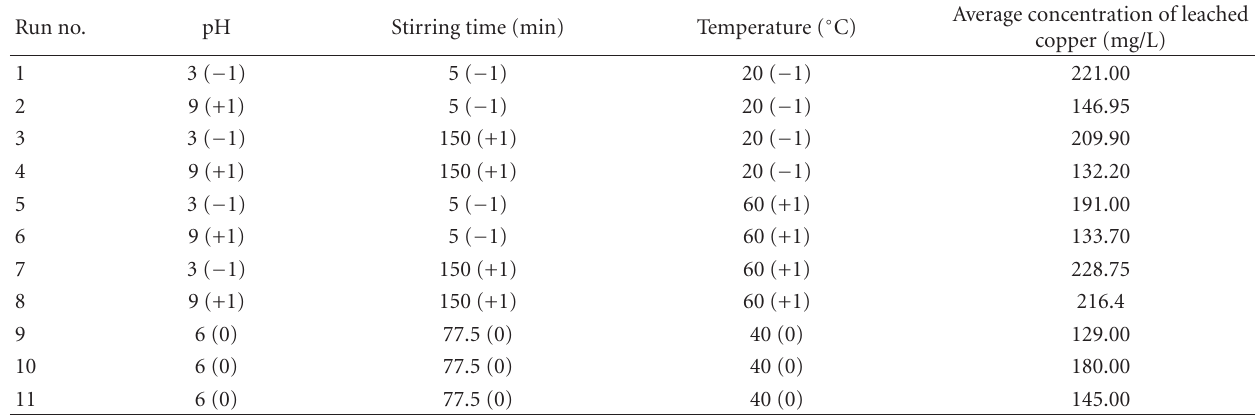
Table 3: Design matrix of the 2 3 full factorial design.